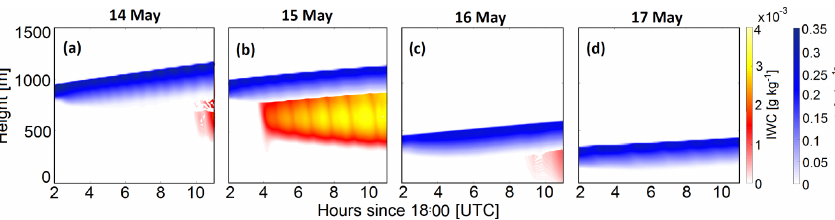
Figure 3. Domain averages of LWC (blue color scale) and IWC (red–yellow color scale) of the four simulations during the VERDI campaign. Please note the different color scale for the IWC in panel (d)